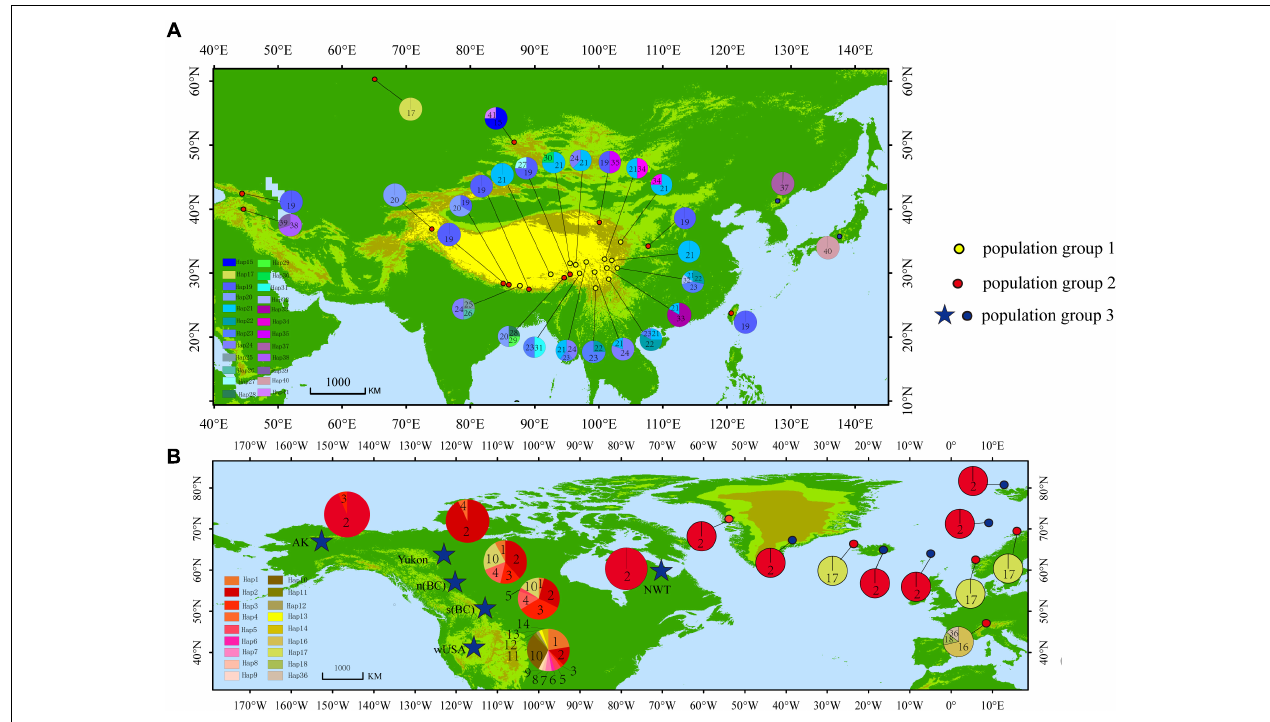
FIGURE 1 | Distribution of haplotypes. (A) Haplotype distribution in Asia. (B) Haplotype distribution in North America and Europe [Modified according to Allen et al. (2015)].